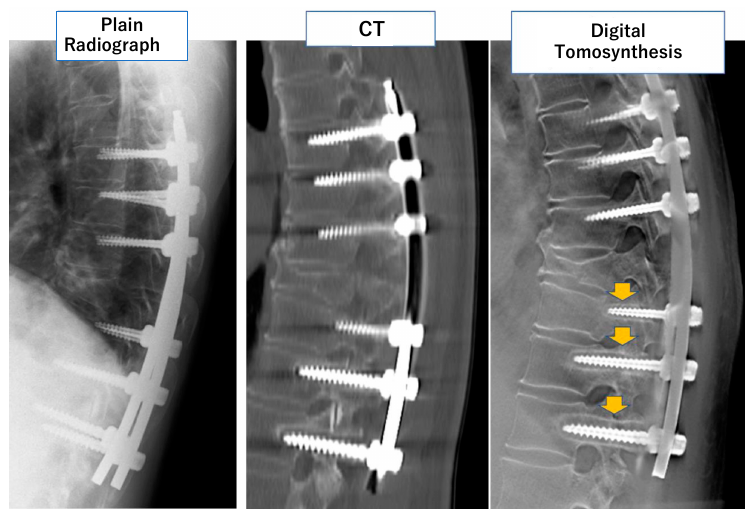
Figure 3. Comparison among plain radiography, computed tomography (CT), and digital tomosynthesis (DT) in an evaluation of pedicle screw loosening after spinal instrumentation. In DT, radiolucent areas around PS were more evident than in images obtained by the two other modalities (arrows).